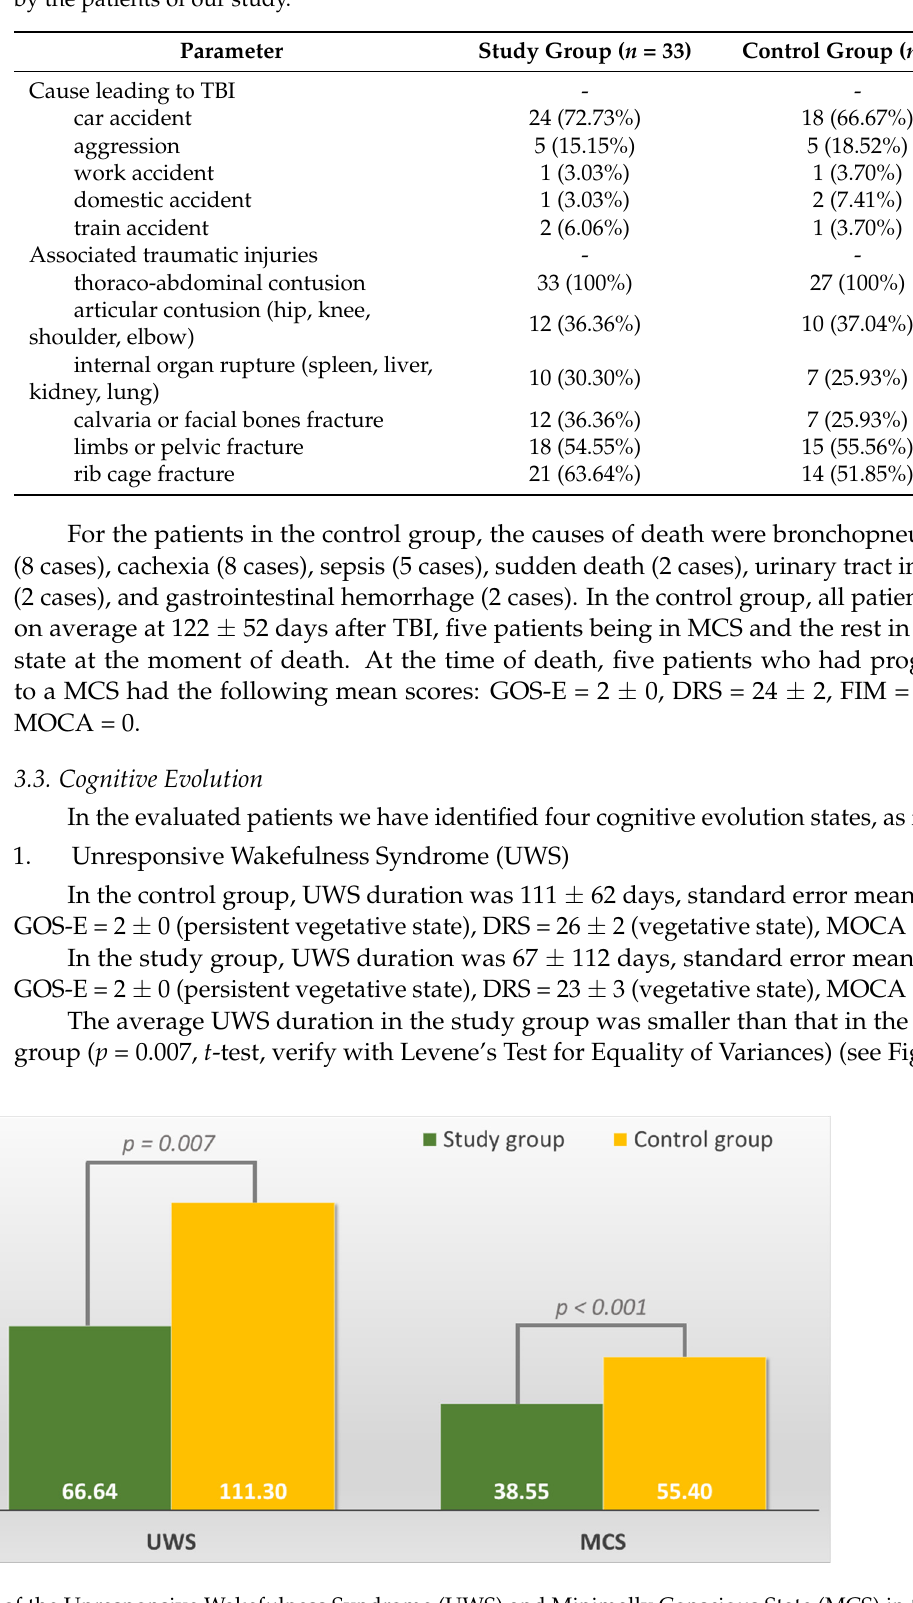
Figure 1. Overall duration of the Unresponsive Wakefulness Syndrome (UWS) and Minimally Conscious State (MCS) in the study versus control group.